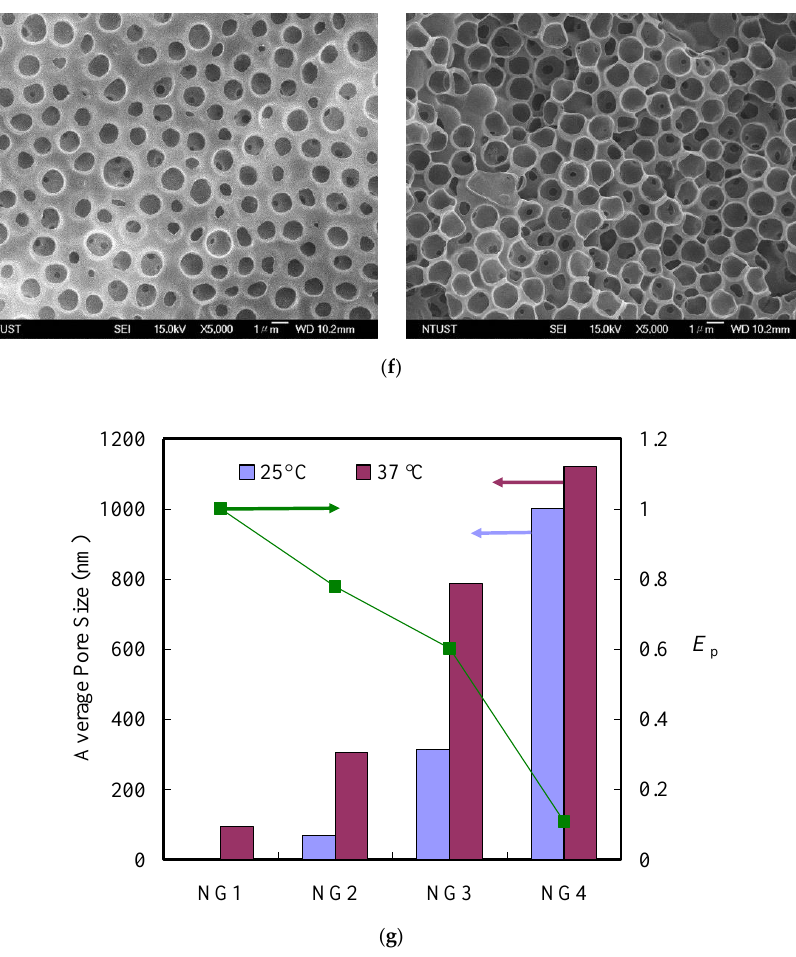
Figure 3. SEM images of ( a ) NG0, ( b ) PN2-included NG0, ( c ) NG1, ( d ) NG2, ( e ) NG3, and ( f ) NG4 at 25 ( left ) and 37 °C ( right ). ( g ) Average pore sizes of NG1, NG2, NG3, and NG4 at 25 and 37 °C and their E p values.